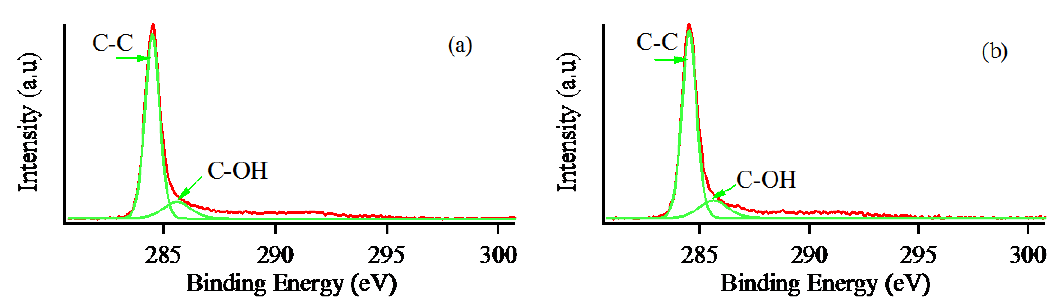
Figure 7. The X-ray photoelectron spectroscopy (XPS) spectra of ( a ) pristine graphite; and ( b ) multilayer graphene. Table 1. Oxygen concentration of pristine graphite and MLG measured by XPS. Sample Concentration (Atomic Weight %) Carbon Oxygen Pristine natural graphite 97.23 2.77 Multilayer graphene 95.52 4.48